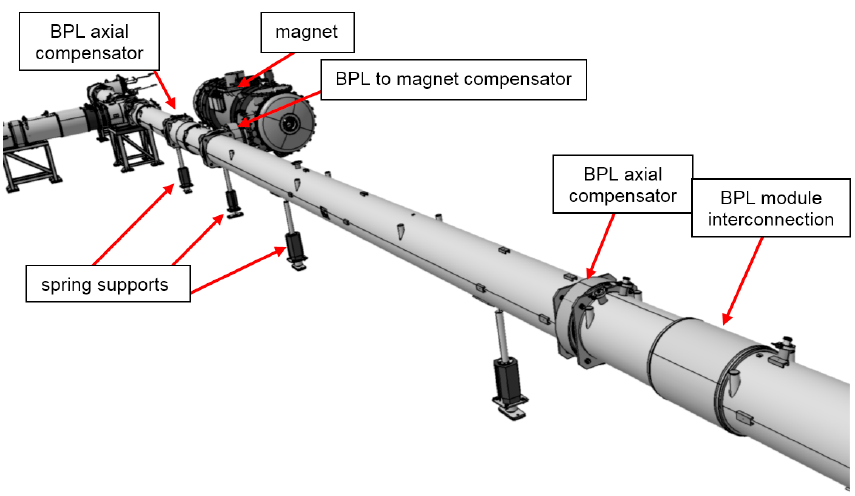
Figure 5. Suspension and compensation of the BPL vacuum vessel.